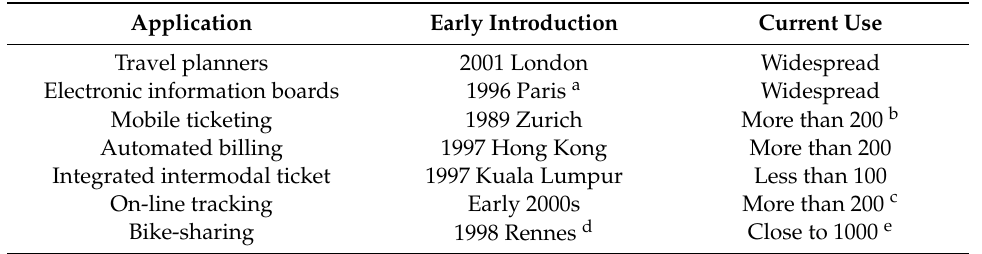
Table 1. The experience with introduction of di ff erent Information and Communication Technologies (ICTs) in urban